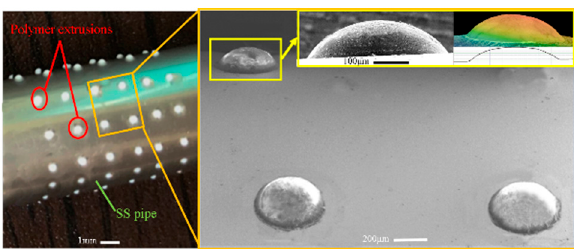
Figure 6. Electroforming mandrel with gibbous extrusion polymer patterns.